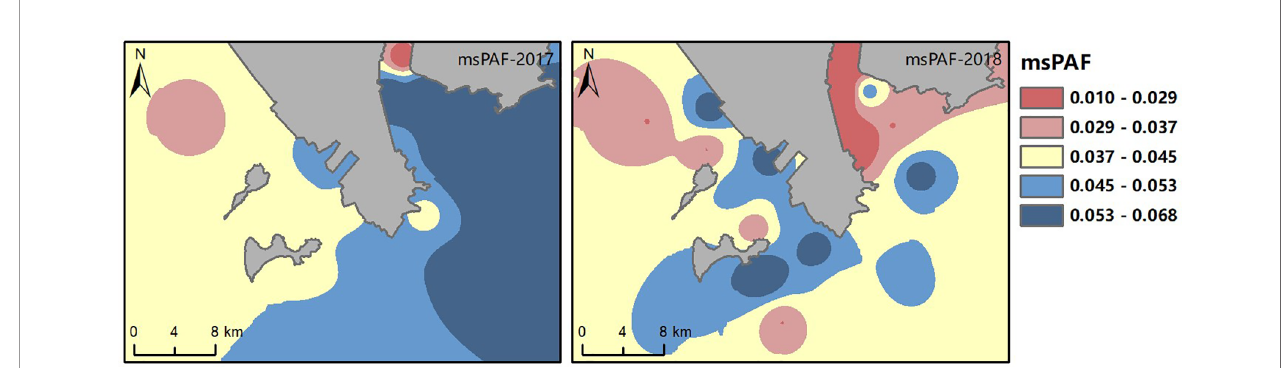
FIGURE 9 | Compound hazard ratio (msPAF) of heavy metals in seawater of